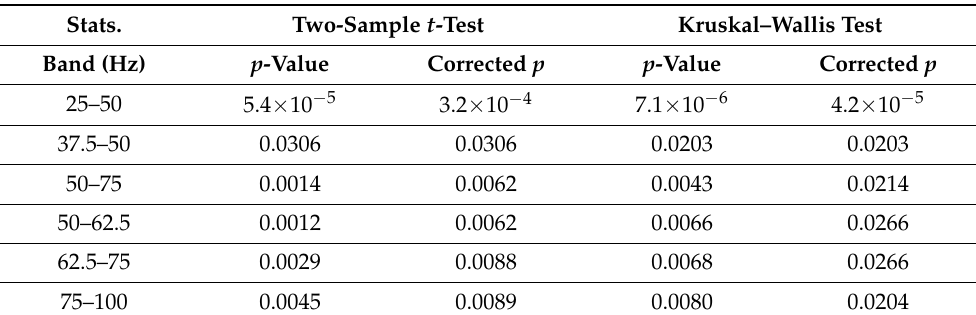
Figure 7. Statistical tests for the proposed wavelet feature, analyzed per dimension using two test approaches. test approaches. Table 3. The p -values and their Holm–Bonferroni corrections for both significance tests. Only the bands (dimensions) with α < 0.05 are